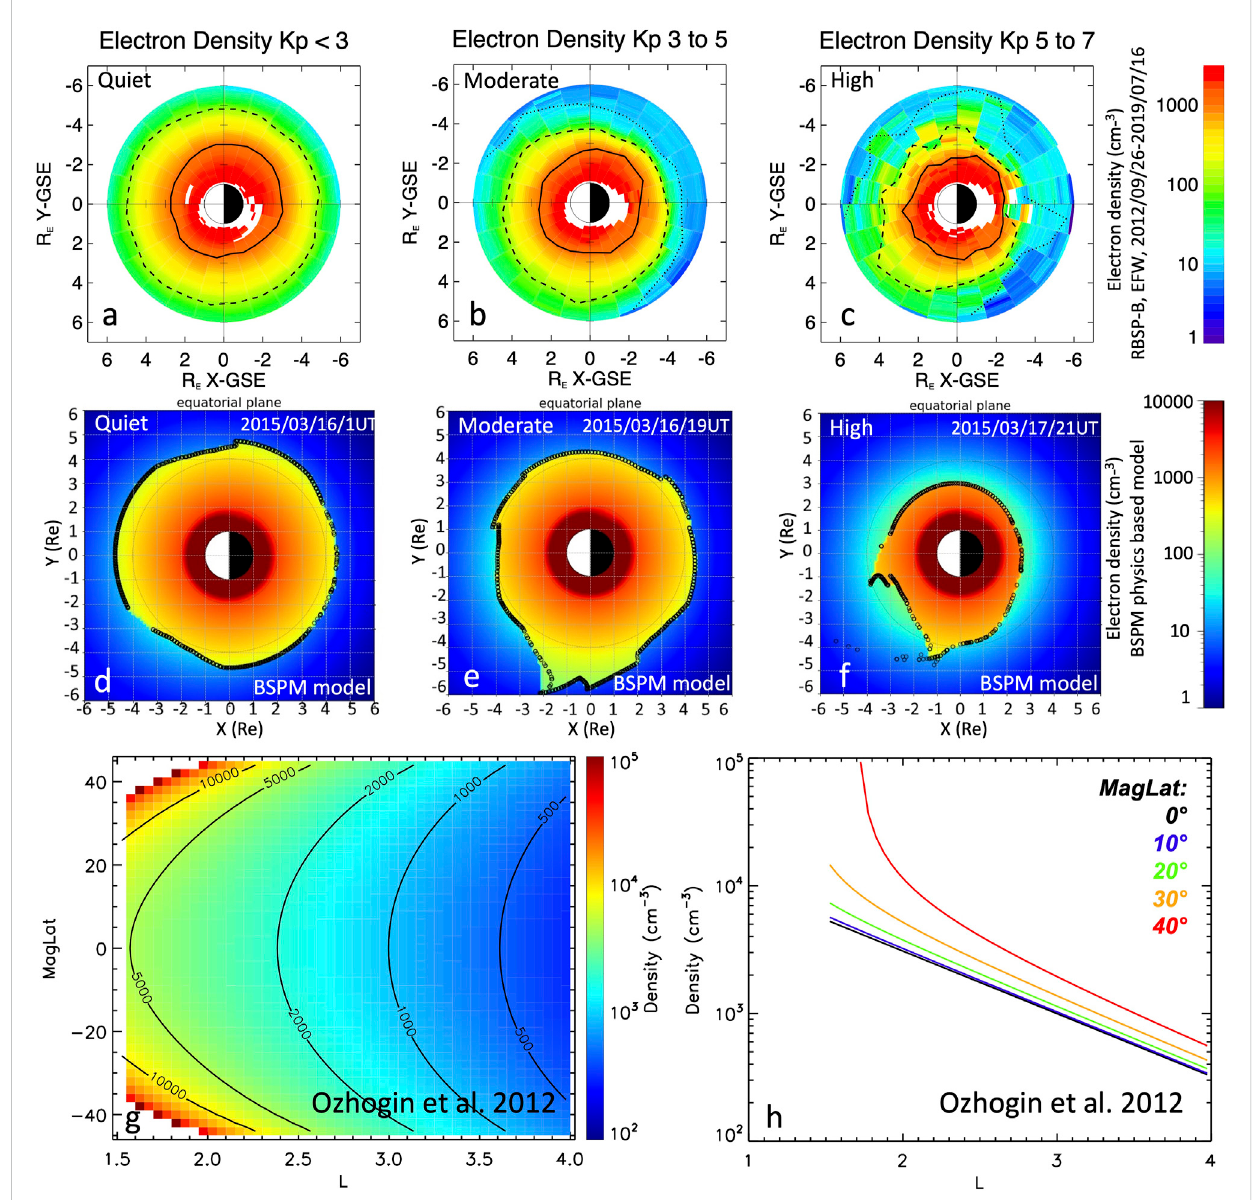
FIGURE 1 (A – C) Statistics of the electron plasma density (log 10 of the density in units cm -3 ) from EFW on Van Allen Probes B during the whole mission (09/ 2012-07/2019) for 3 Kp bins of geomagnetic activity (Ripoll et al., 2022a). (D – E) The physics-based Belgian SWIFF Plasmasphere Model (BSPM) model of (color scale) the electron density and (black circles) the plasmapause during times of (D) quiet, (E) substorm, and (F) storm activity (Pierrard et al., 2021b). TheempiricalOzhoginetal.(2012)densitymodelderivedfromtheIMAGERadioPlasmaImager(RPI)measurementplotted (G) versus L-shell(L)and magnetic latitudes and (H) versus L-shell extracted at a few magnetic